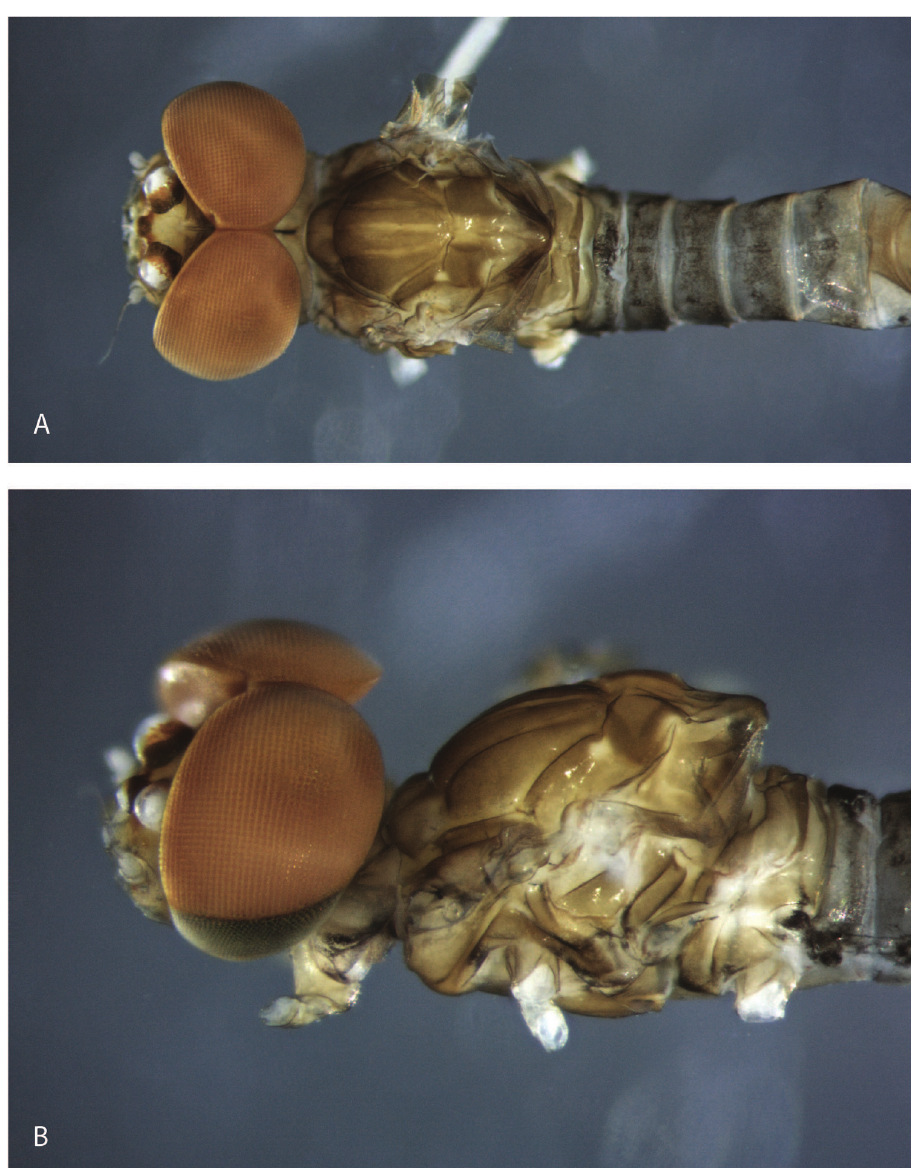
Figure 3. Hydromastodon sallesi , male imago: a dorsal view b head and thorax, lateral view.